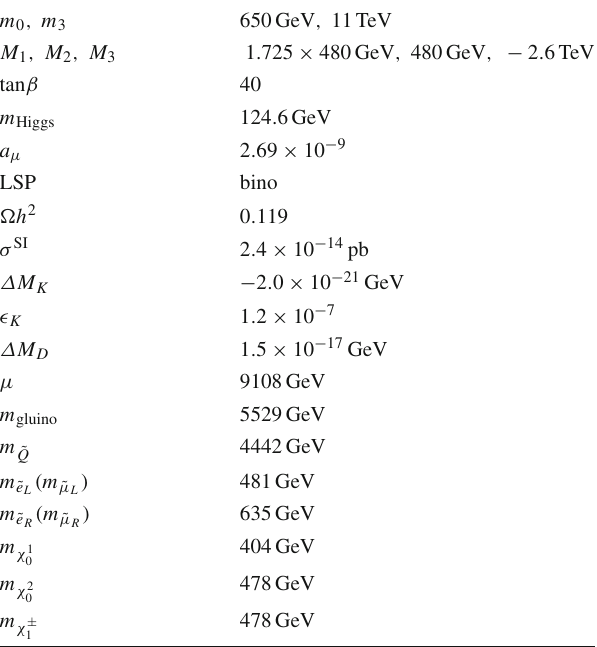
Fig. 4 The summary plots for the collider constraints and the dark matter candidate. The same with Fig. 2 for the parameter space and the color codes. On the right (left) side of the black dashed line, the neutralino (the sneutrino) is the LSP. The blue shaded regions are excluded from the collider searches at 95%CL. On the green line, the observed current dark matter abundance (cid:7) h 2 (cid:4) 0 . 12 is achieved due to the bino-wino coannihilation